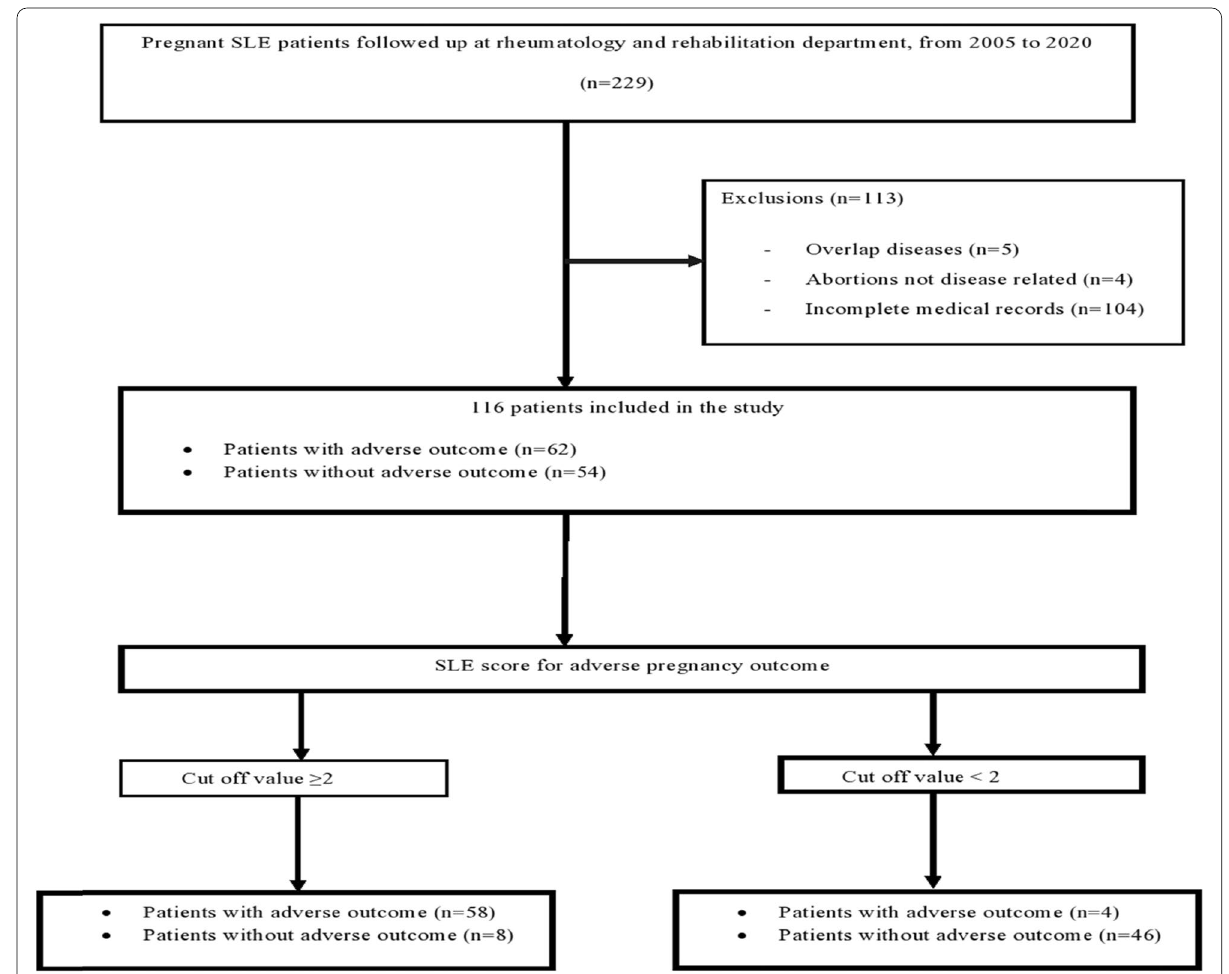
Fig. 1 Flowchart displaying the cutoff values for the risk score model predicts adverse outcomes in pregnant lupus